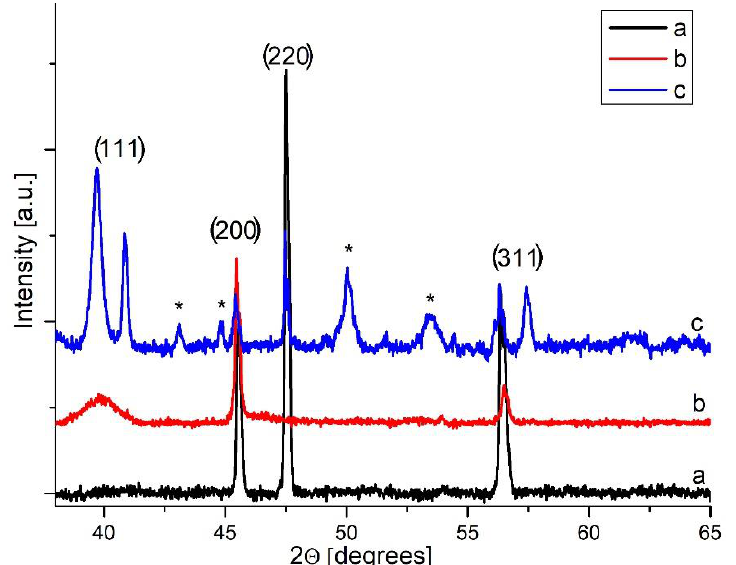
Figure 9. XRD diagrams for: (a) CuNPs; (b) PtNPs; (c) Pt@CuNPs.